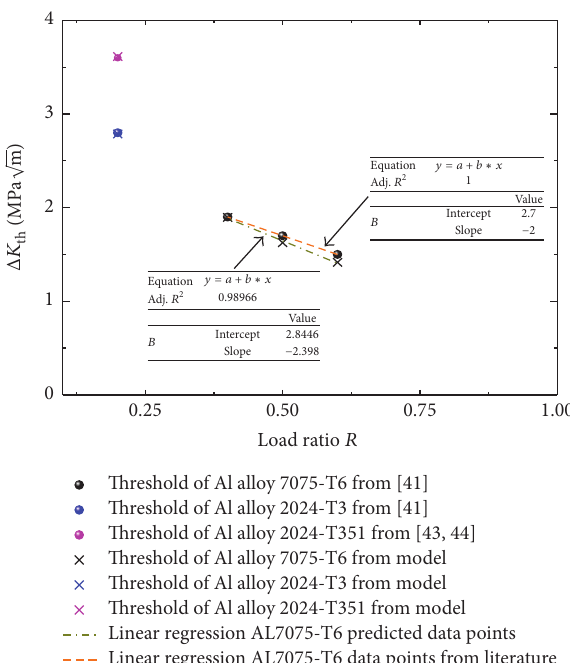
Figure 10: Threshold versus load ratio data where thresholds of model and literature are